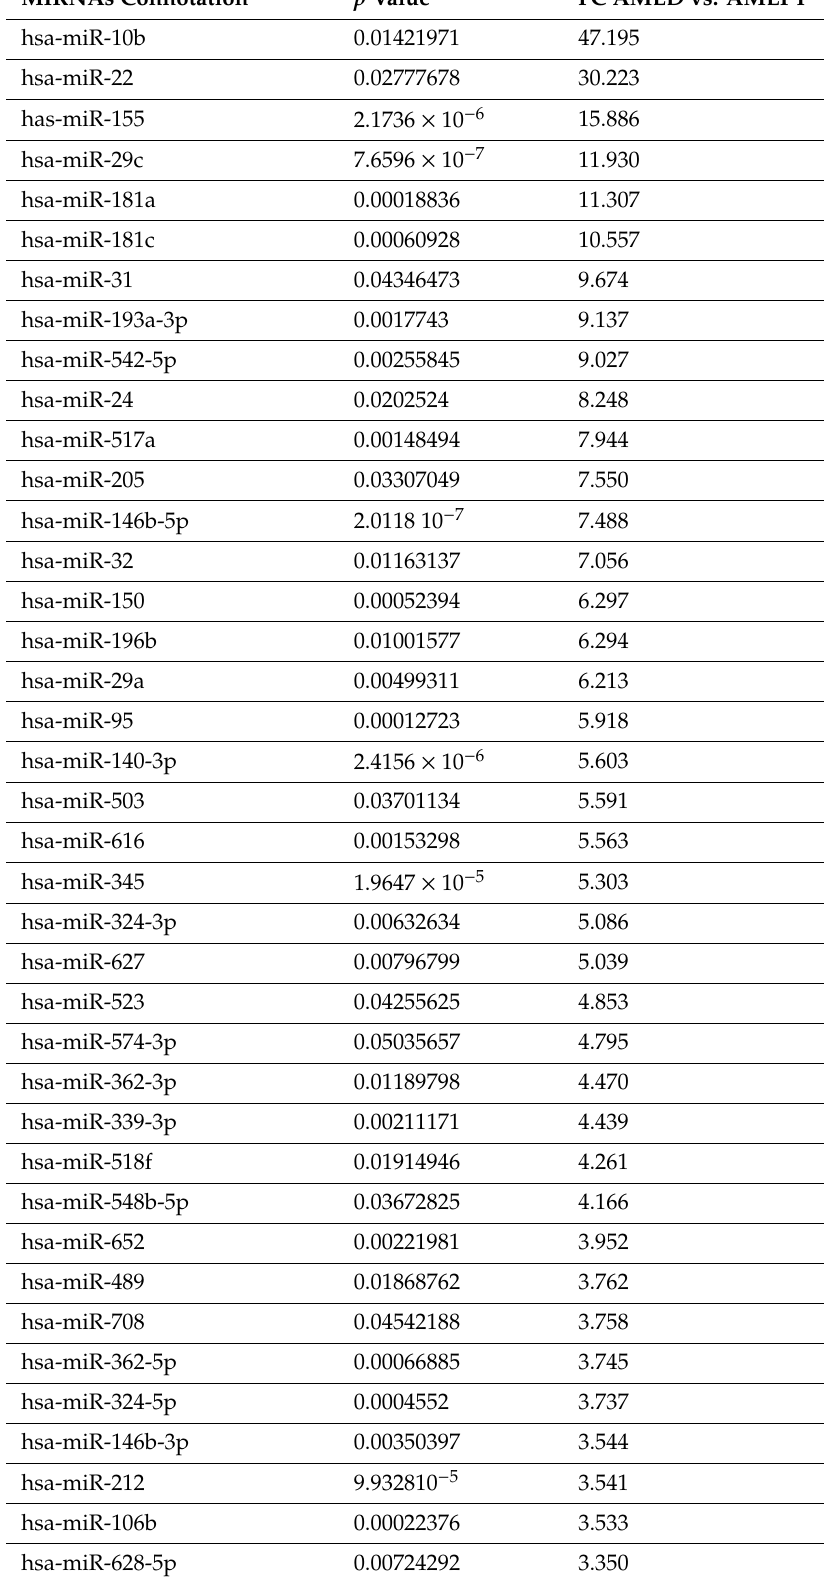
Table 5. Di ff erentially expressed bone marrow circulating miRNAs between newly diagnosed (AMLD) and first complete remission post-treated (AMLPT) AML